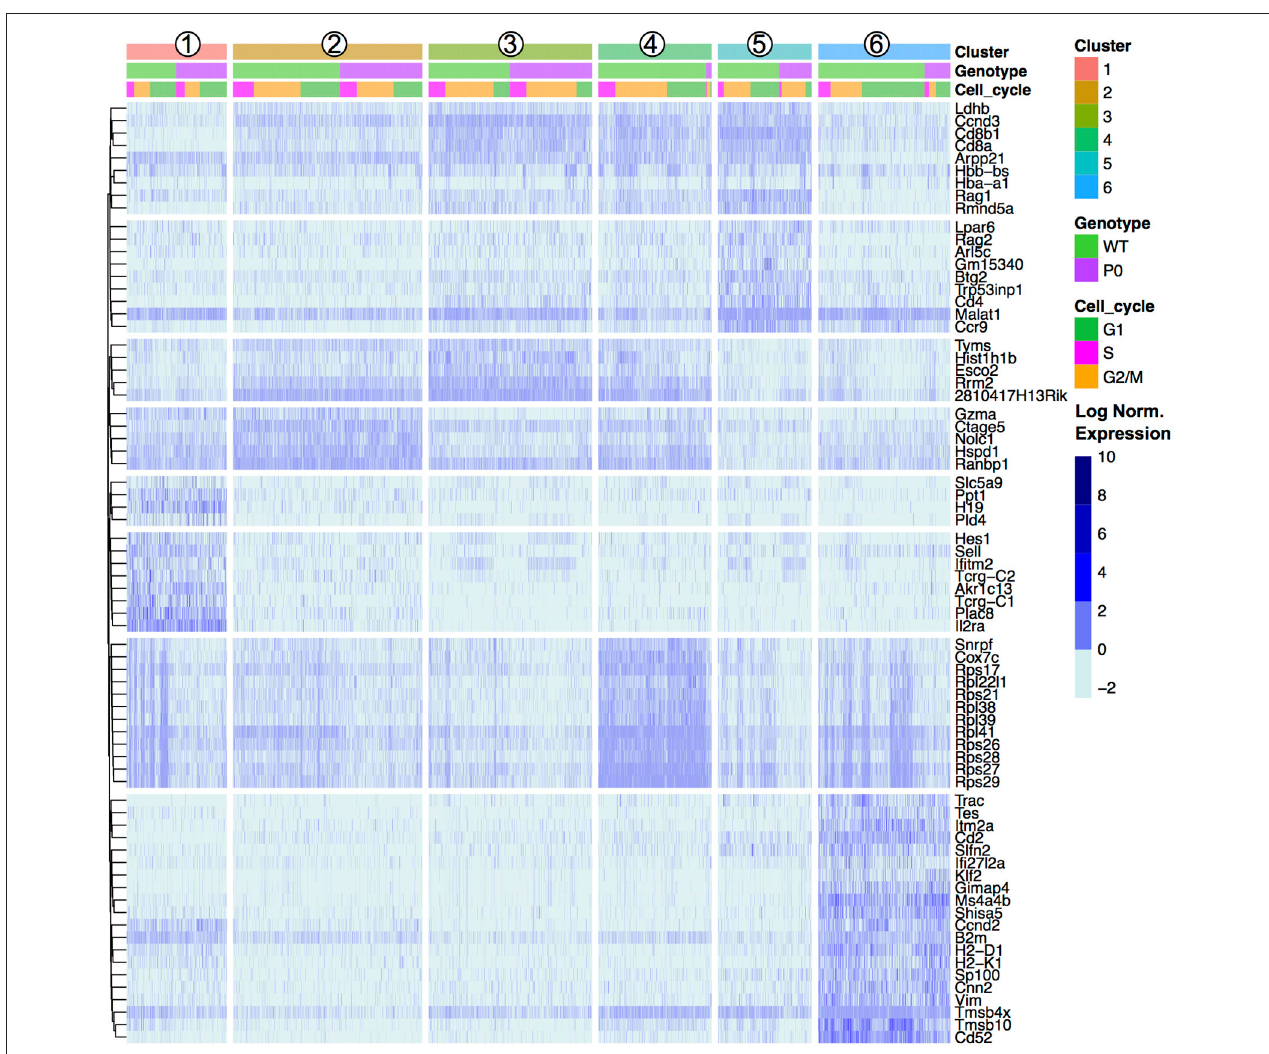
FIGURE 3 | Unsupervised Clustering Driven by T-Cell, Cell Cycle, and Ribosomal Genes. Transcript levels of each cluster were compared with the remaining overall cell population. The top 20 genes with an absolute fold change above 5 and an adjusted p- value < 0.01 for each cluster were visualized in a heat map and ordered by genotype (WT vs. P 0 ) followed by cell cycle score (G1, G2/M, or S). The top 20 genes for each of the six clusters results 120 genes, reduced to 72 unique entries. Each column represents one cell. Signal intensities are shown on a log 2 scale. The complete gene lists are provided in Dataset S1 .